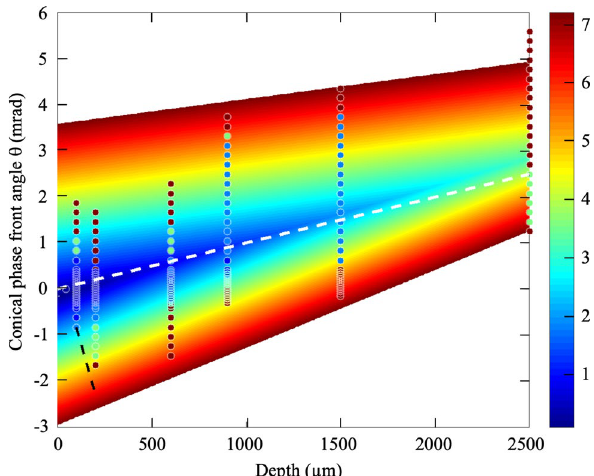
Figure 6. Onset laser energy for Kerr and plasma focussing under influence of surface aberration and conical phase front angle. The onset single-pulse energy (circles with false colour energy scaling) for Kerr lensing and plasma defocussing effects, tested from 270 nJ to 7.2 µJ, and plotted as a function of focal depth (44 to 2500 µm) and conical phase front angle (~ − 2.5 < θ < + 3.5 mrad). The onset was noted when modification tracks deviated from simulated intensity profiles. The data were represented by a model of two intersecting planes (false colour) with a vertex following closely with the conical phase front angle (white dashed line) found to compensate the surface aberration with a minimized depth of focus DOF min (θ opt (z)). The black dashed line marks the minimum (negative) conical angle observed to avoid surface ablation with increasing focal